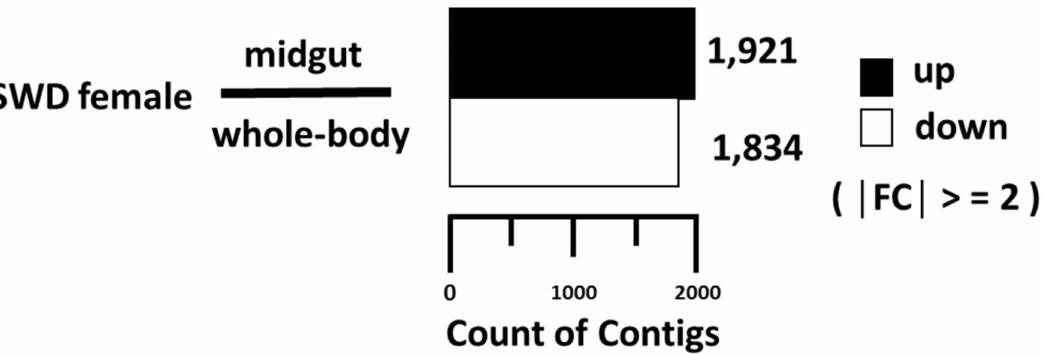
Figure 1. Up- and down-regulated gene counts in Drosophila suzukii female midgut compared to its whole-body. 1921genes were up-regulated, and 1834 genes were down-regulated.